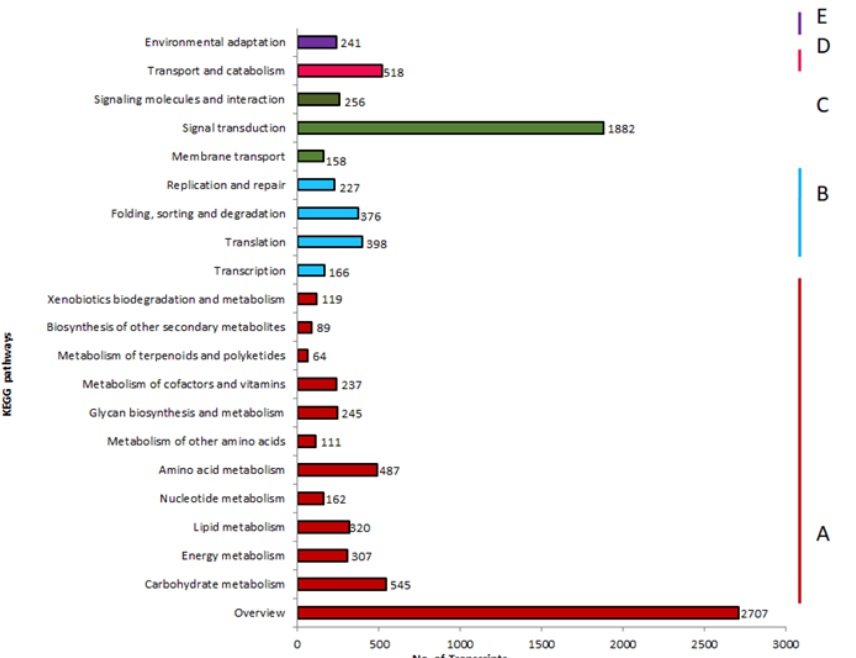
Figure 4. KEGG Pathway classification of assembly A: Metabolism B: Genetic Information Processing C: Environmental Information Processing D: Cellular Processes E: Organismal Systems. No. of transcripts is represented on the x-axis under different KEGG pathway classes represented on the y-axis.